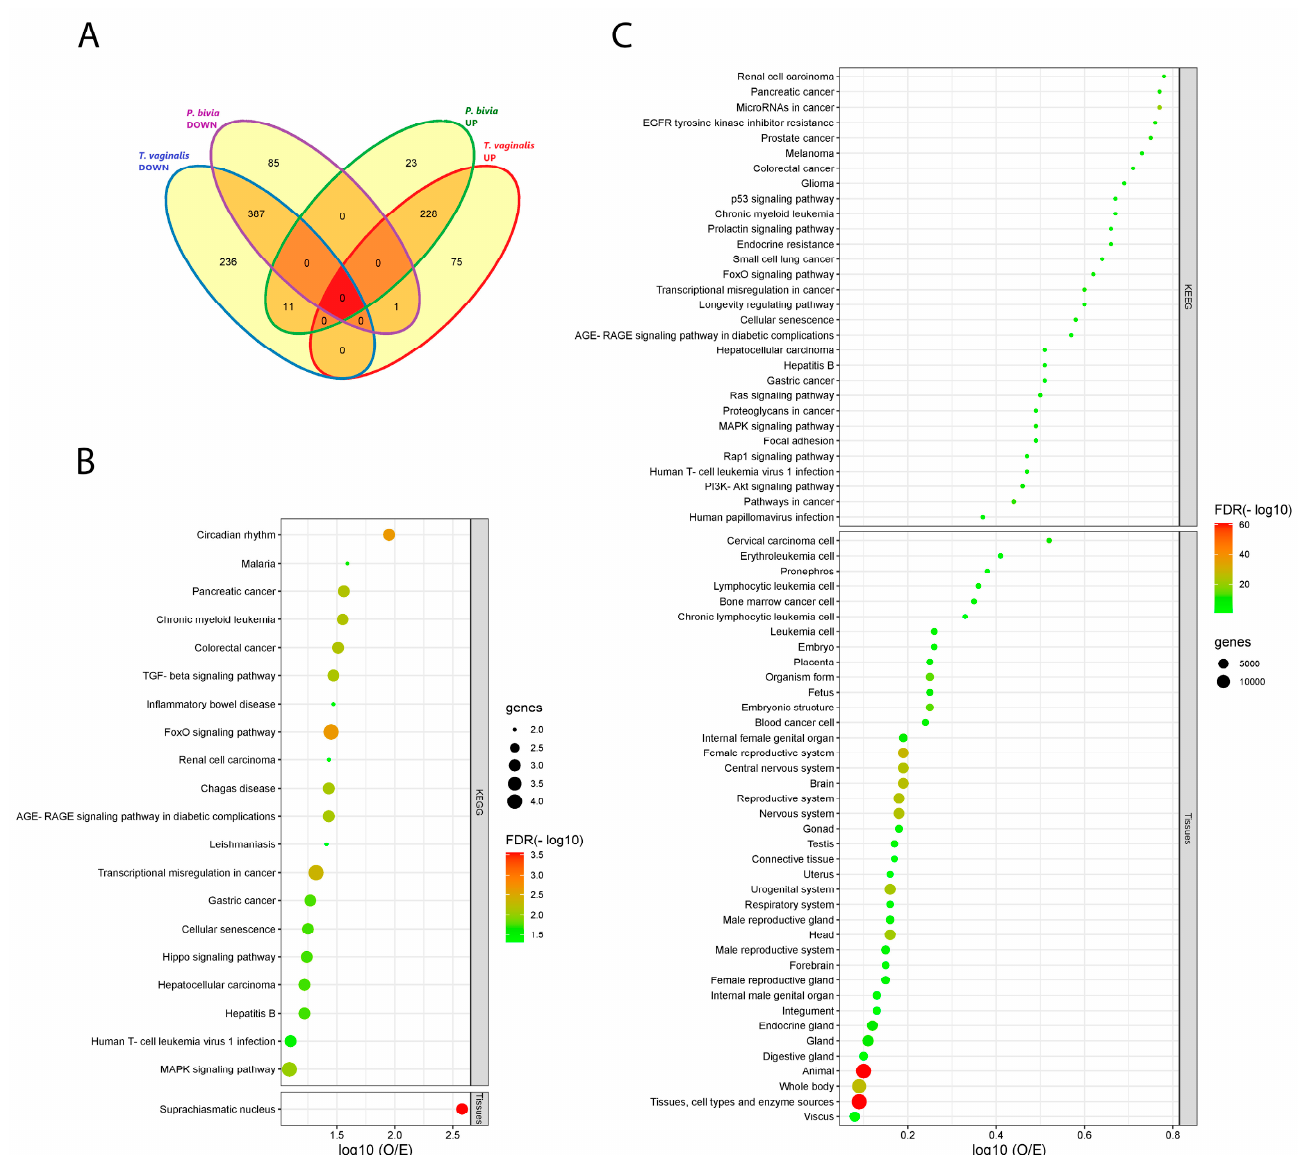
Figure 3. T. vaginalis and P. bivia triggered similar patterns of EV-miRNAs dysregulation, linking both to common pathway signatures in cancer and reproductive tissues. ( A ) Venn diagram depicts the number of shared and unique EV-miRNAs modulated by T. vaginalis and P. bivia in each category. ( B ) Total terms enriched in KEGG and in TISSUES respective to shared down-regulated EV-miRNAs targets. ( C ) Top-30 terms enriched in KEGG, and the totality of terms found in TISSUES respective to shared up-regulated EV-miRNAs targets. Bubble charts in B and C portray enriched pathways generated in STRING for the validated targets of EV-miRNAs up- (228) or down-regulated (387) by both T. vaginalis and P. bivia. Pathways were ranked by strength of the enrichment effect as the log10 (O/E) ratio. The size of the bubbles represents the number of validated targets in each pathway. Color gradient reflects the level of the false discovery rate (FDR) significance ( − log10).